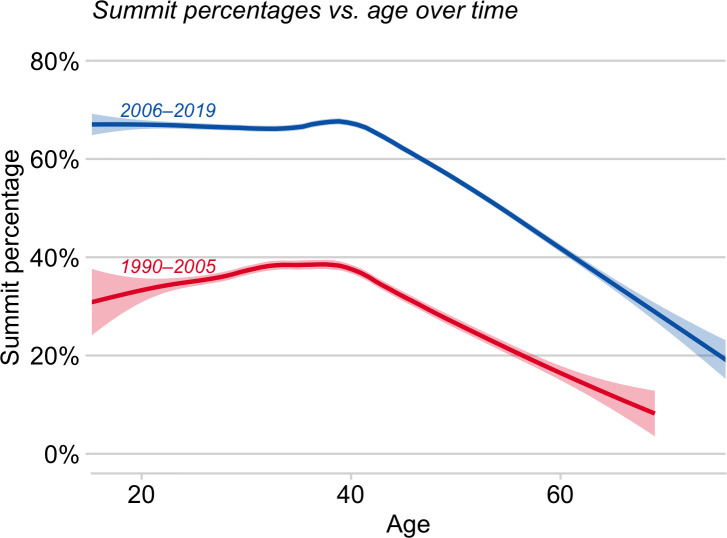
Fitted probabilities (GAM) of summiting vs. climber age for early (1990–2005, red) and recent (2006–2019, blue) cohorts.Probabilities of summiting declined for climbers older than ~ 40, but recent climbers of all ages had greatly elevated probabilities of summiting relative to early climbers. Solid lines are from local linear smoothing, and the adjacent shading represents the 95% confidence region for the expected summit probability as a function of age.